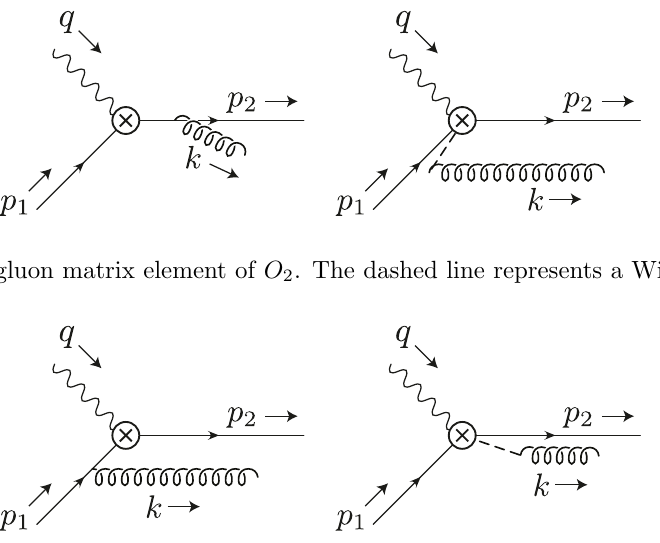
Figure 3 . (cid:22) n sector gluons emitted into the (cid:12)nal state. The dashed line indicates the Wilson line W y (cid:22) n